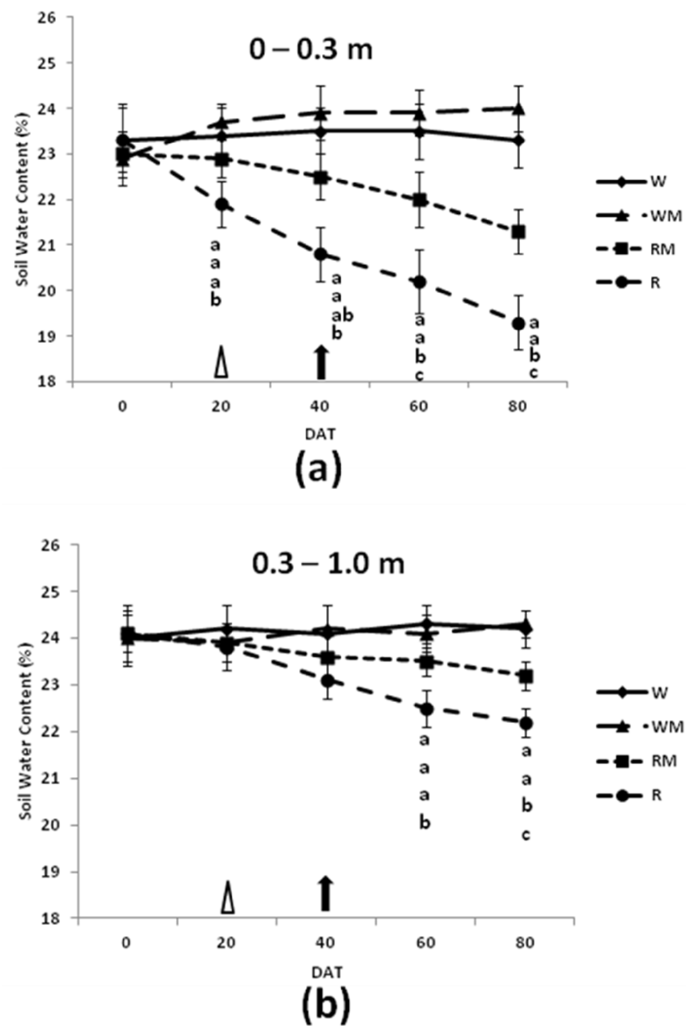
Figure 1. Changes in soil water content (%) in the 0–0.3 m ( a ) and 0.3–1.0 m ( b ) soil layers of spearmint exposed to the following treatments: R—rainfed without straw mulch, RM—rainfed with straw mulch, W—well-watered control plants and WM—well-watered with straw mulch. Measurements were performed 0, 20, 40, 60 and 80 days after the onset of the treatments (DAT). Vertical bars represent ± SE of the mean ( n = 5). Bars with different letters indicate significant differences among treatments in the given DAT at p ≤ 0.05. Triangle at 20 DAT indicates the early bloom, and arrow at 40 DAT indicates the full bloom, in overall treatments.